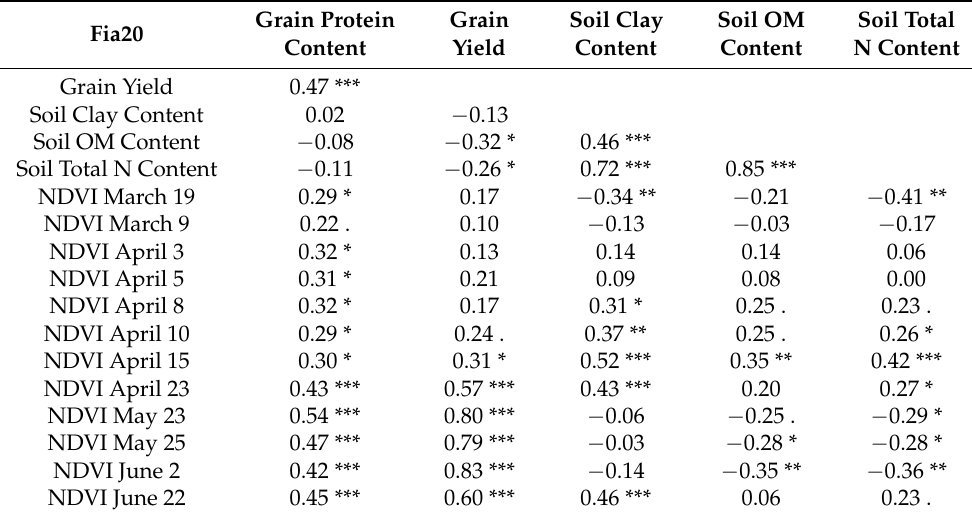
Table 10. Pearson correlation analysis and significance levels (. = 0.10; * = 0.05; ** = 0.01; *** = 0.001) between NDVI, grain yield, protein content, and soil parameters for the Fia20 field.